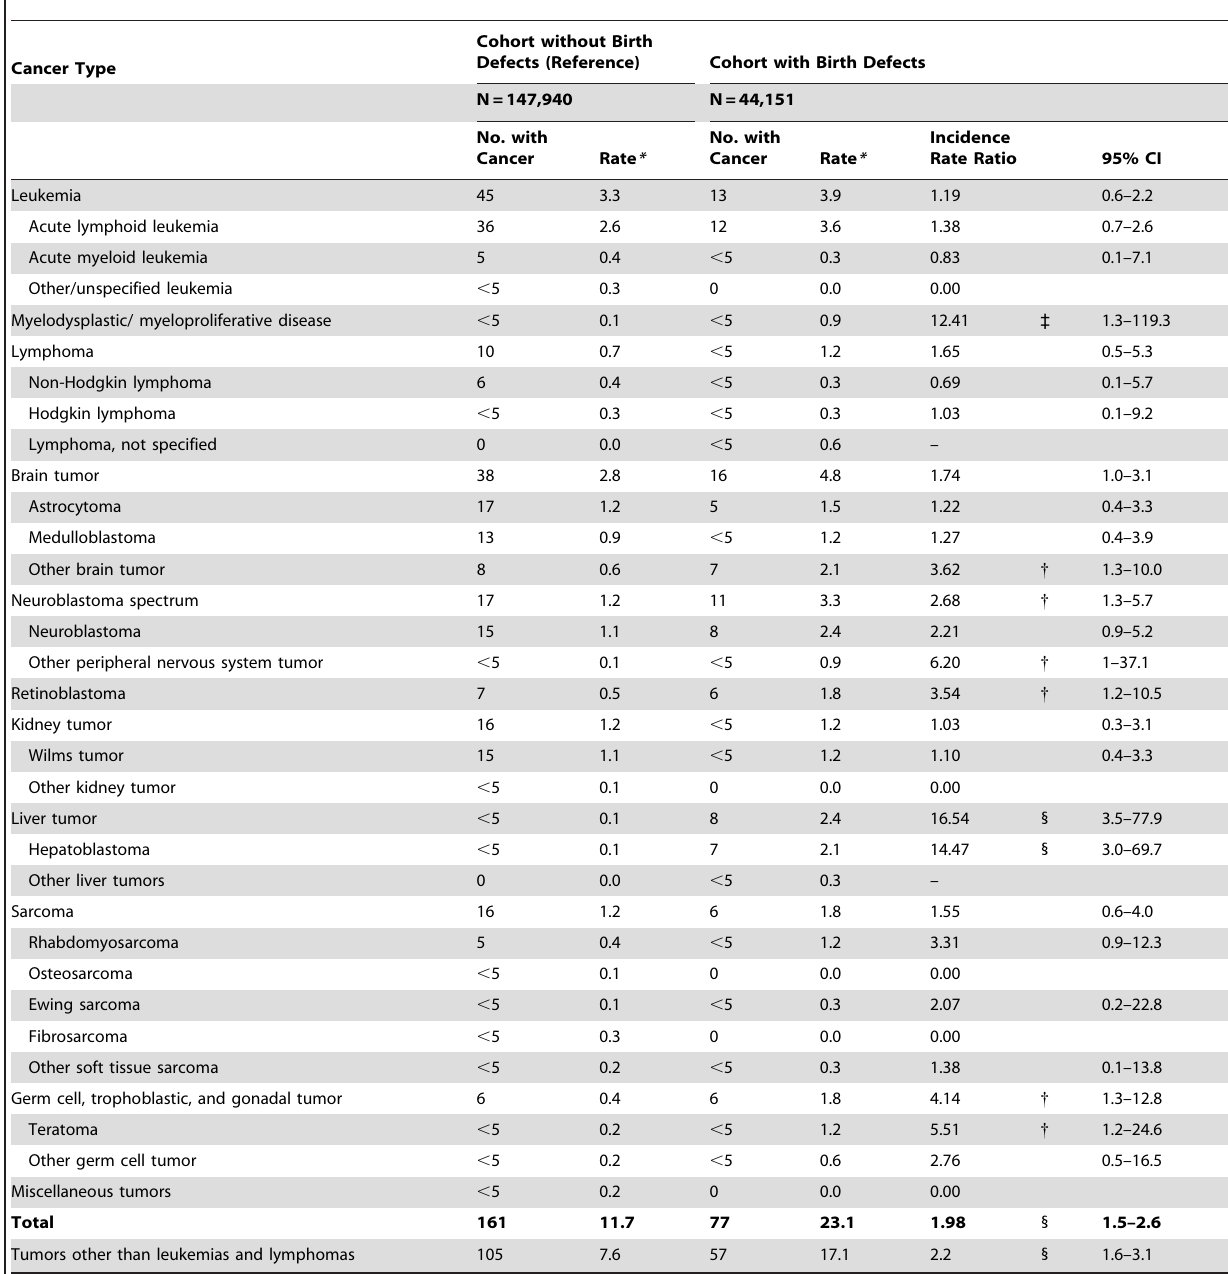
Table 4. Risk for specific types of cancer in children with structural birth defects, UTAZIA study. Chromosomal conditions were